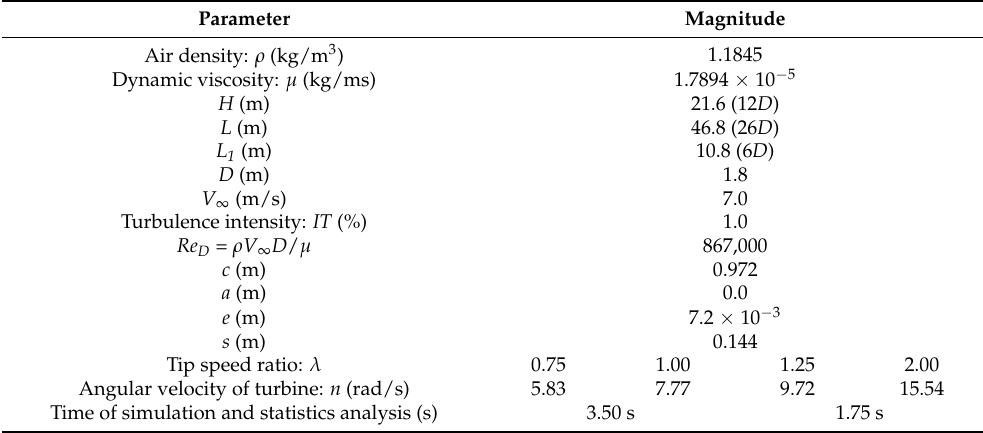
Table 1. Parameters used in the verification/validation case ( Case 1 ).